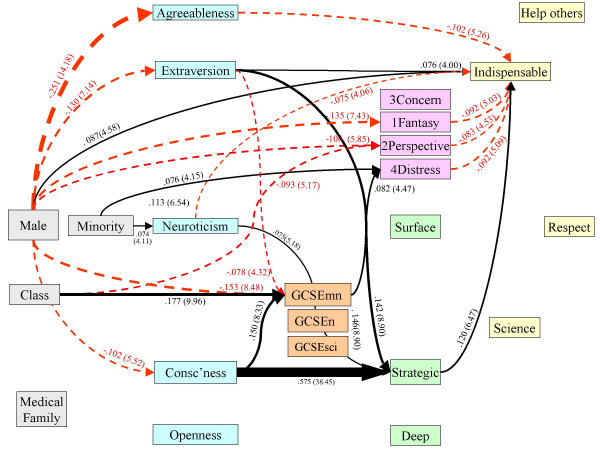
A reduced version of figure 1 in which the only paths shown are those with direct or indirect influences upon generic motivational factor 2 (Helping people). All variable names have been left in the diagram, and are in the same positions as in figure 1.